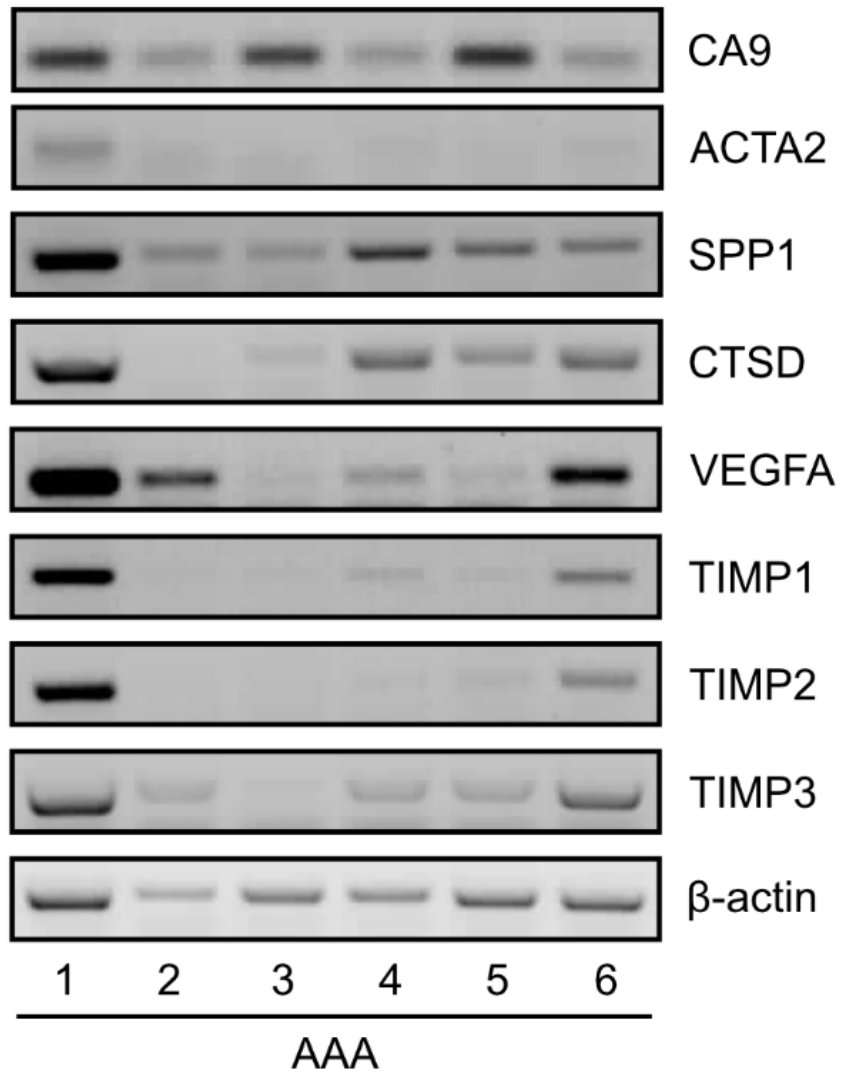
Figure 3. Representative semiquantitative PCR of CA9 , ACTA2 , SPP1 , CTSD , VEGFA , TIMP1 , TIMP2 , and TIMP3 in human AAA tissues. Detection of β -actin served as a control.